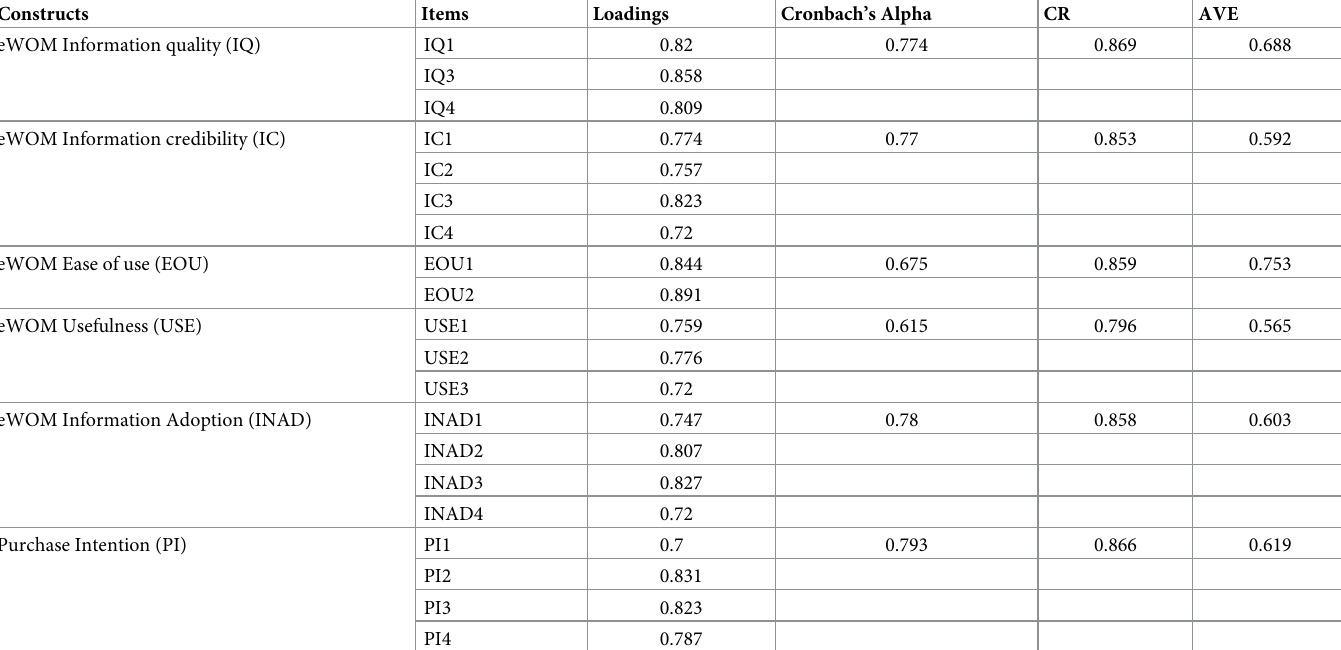
Table 2. Construct validity